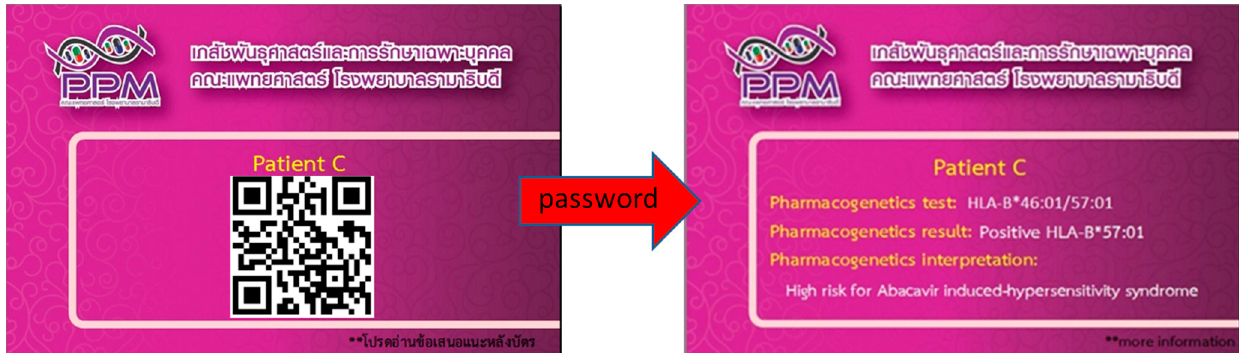
Figure 6. The PPM card is a pharmacogenomics identity card (PGx ID card). The QR code will be used to increase the security and confidentiality of the patient’s genetic information. It can be accessed by the pharmacogenetics information of individual patient by private password .